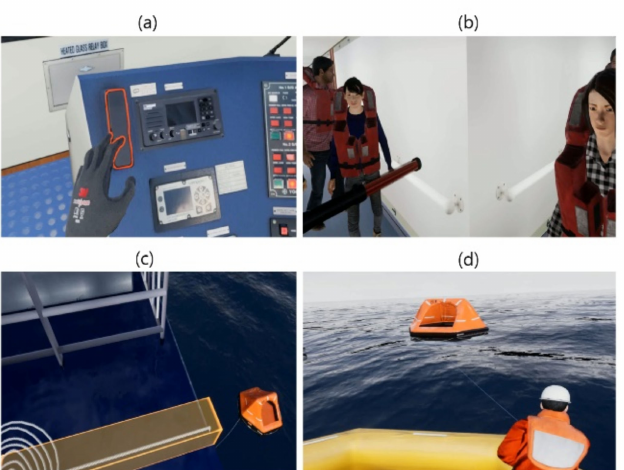
Figure 3. VR contents: ( a ) announce, ( b ) escape from cabin to muster station, ( c ) evacuation system, ( d ) operation of life-raft.